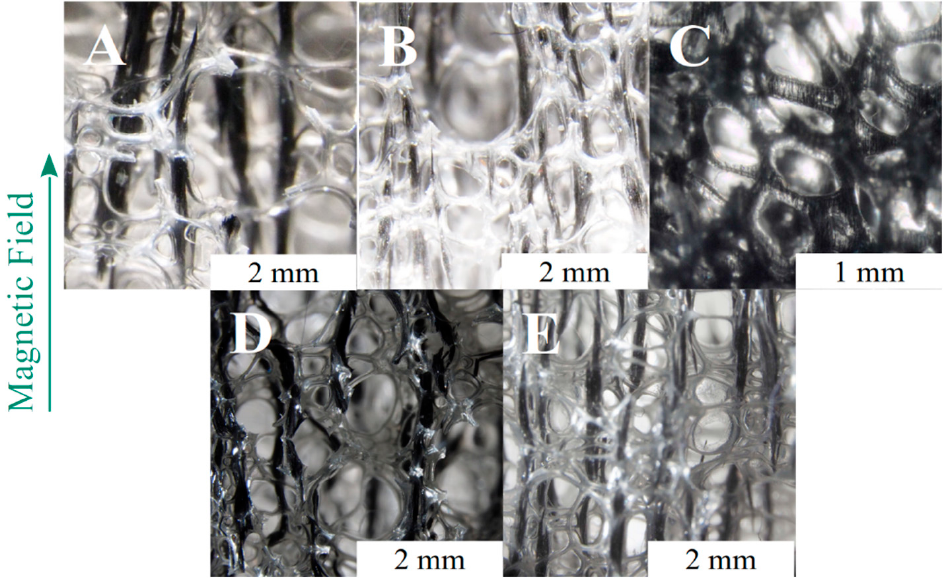
Figure 6. Optical micrographs of the following samples: ( A ) AF_189_T0-10, ( B ) AF_189_T0.5-10, ( C ) AF_189_T2-10, ( D ) AF_189_T0-1, ( E ) AF_189_T0-2.